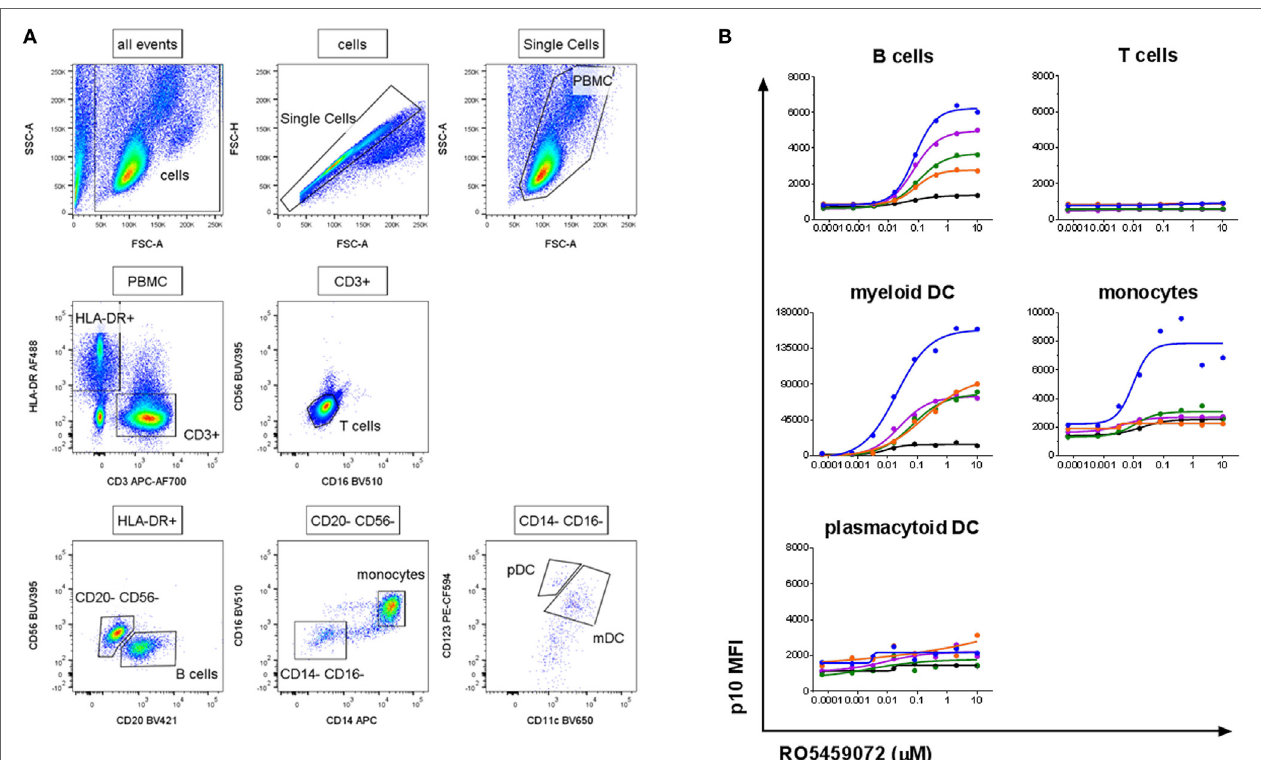
FIgURe 2 | Detection of a dose-dependent Lip10 intracellular accumulation in professional antigen-presenting cell (APC) subsets. (A) Representative gating scheme used for Lip10 detection in immune subtypes with a flow cytometry-based assay. (B) Lip10 accumulation [p10 median fluorescence intensity (MFI)] in different immune subtypes was assessed by flow cytometry after in vitro incubation of PBMC with a serial titration of RO5459072. Data represent five individual healthy volunteers, identified by identical individual colored lines and dots across graphs. Curve fit was determined by non-linear regression using a variable slope model with GraphPad Prism